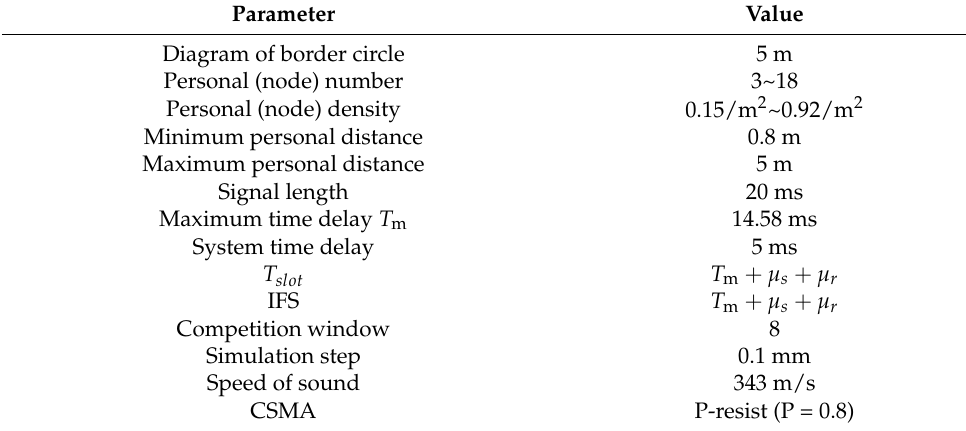
Table 2. MAC simulation settings.